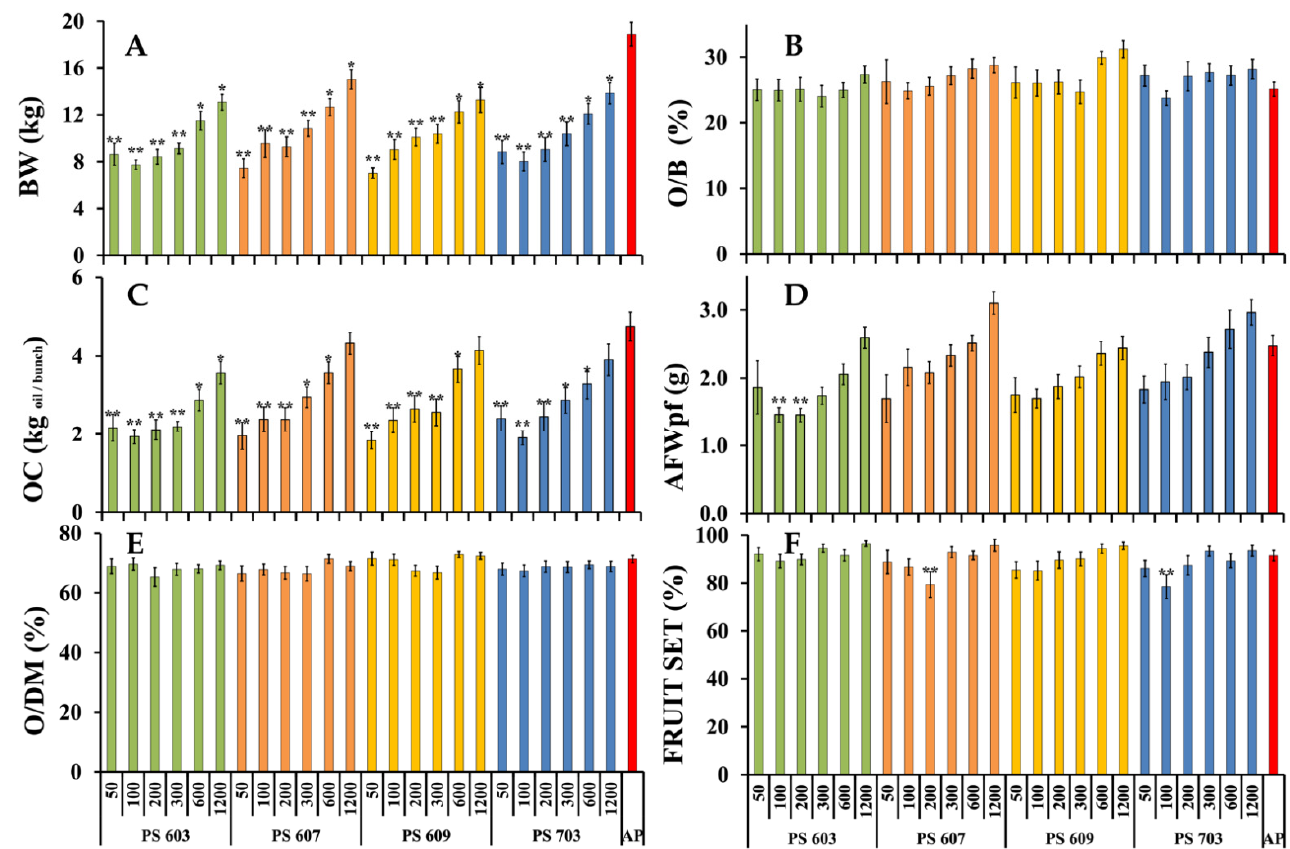
Figure 2. Effect of single applications of different NAA concentrations on the bunch components in OxG hybrids (Coari x La Mé). The NAA solutions were applied once at different phenological stages (PS) (603, 607, 609, 703), represented by the different colors. Assisted pollination treatment was performed only in inflorescences in anthesis (phenological stage 607), represented by the red bar. ( A ) Average bunch weight (BW). ( B ) Oil to bunch (O/B). ( C ) Oil content per bunch (OC). ( D ) Average fruit weight of parthenocarpic fruits (AFWpf). ( E ) Oil to dry mesocarp (O/DM). ( F ) Fruit set. Statistically significant differences between assisted pollination (AP) as commercial control and the NAA treatments across dosages/PS are indicated by asterisks (One-Way ANOVA, Dunnett’s test, * = p < 0.05, ** = p < 0.01).